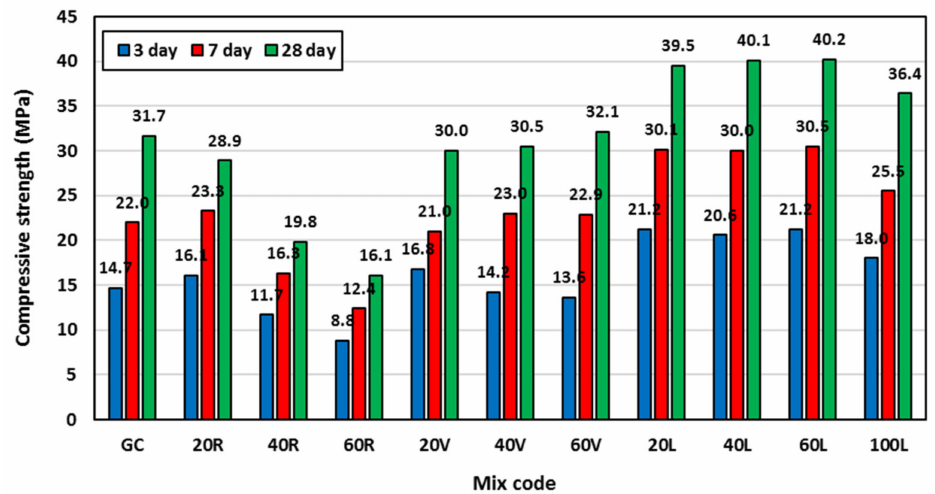
Figure 8. Concrete compressive strength at different concrete ages for all